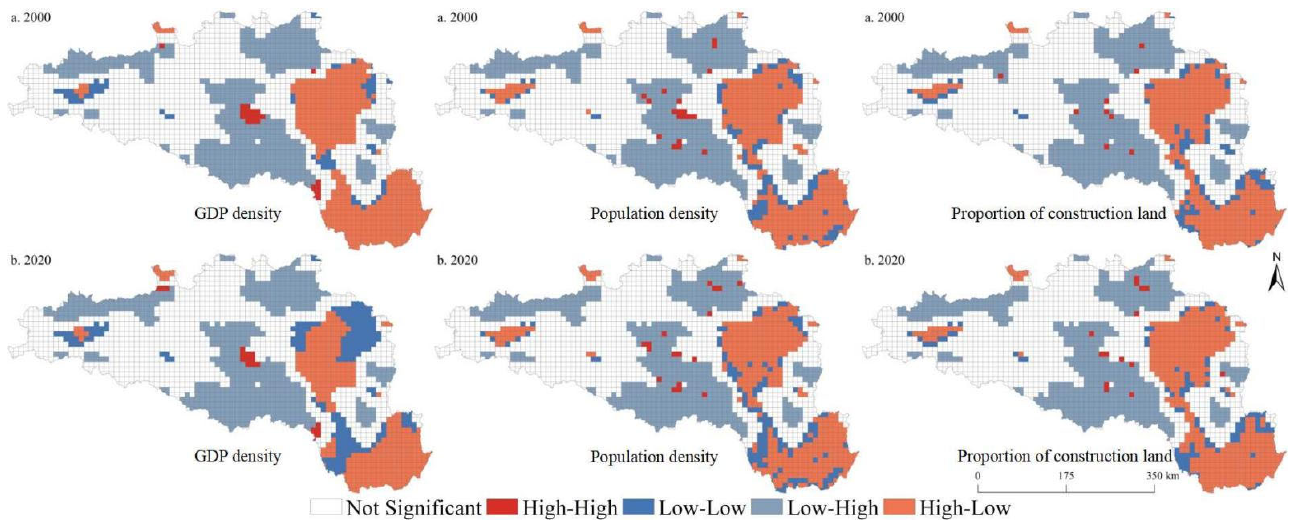
Figure 6. LISA map of urbanization elements and ESBI at the 5 km grid scale in the HREEB in China.